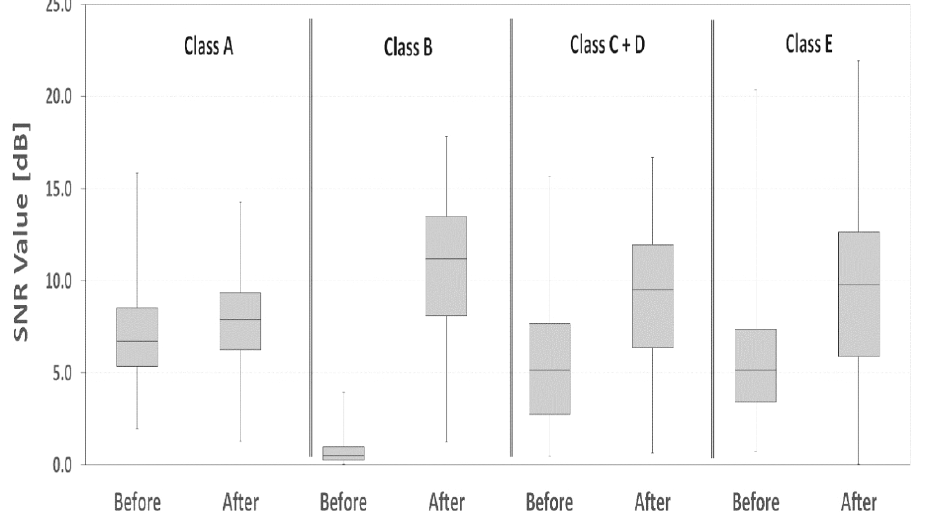
Figure 5. SNR measurements on all HS recordings on all classes before and after utilizing DTCWT.